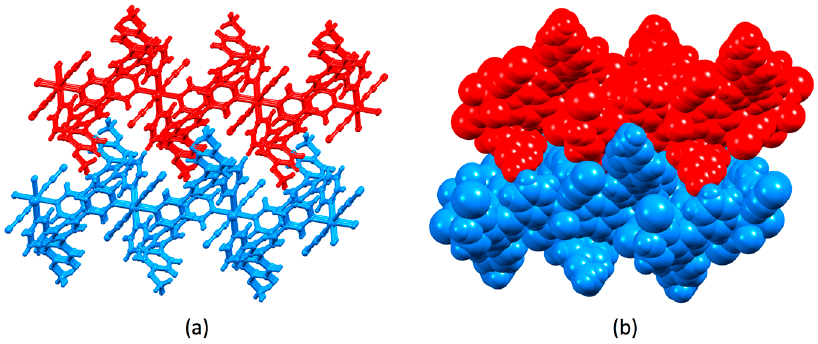
Figure 10. Parts of two adjacent 2D sheets in [Co( 2 ) 2 (NCS) 2 (MeOH) 2 ] n : ( a ) ball-and-stick and ( b ) space-filling representations.